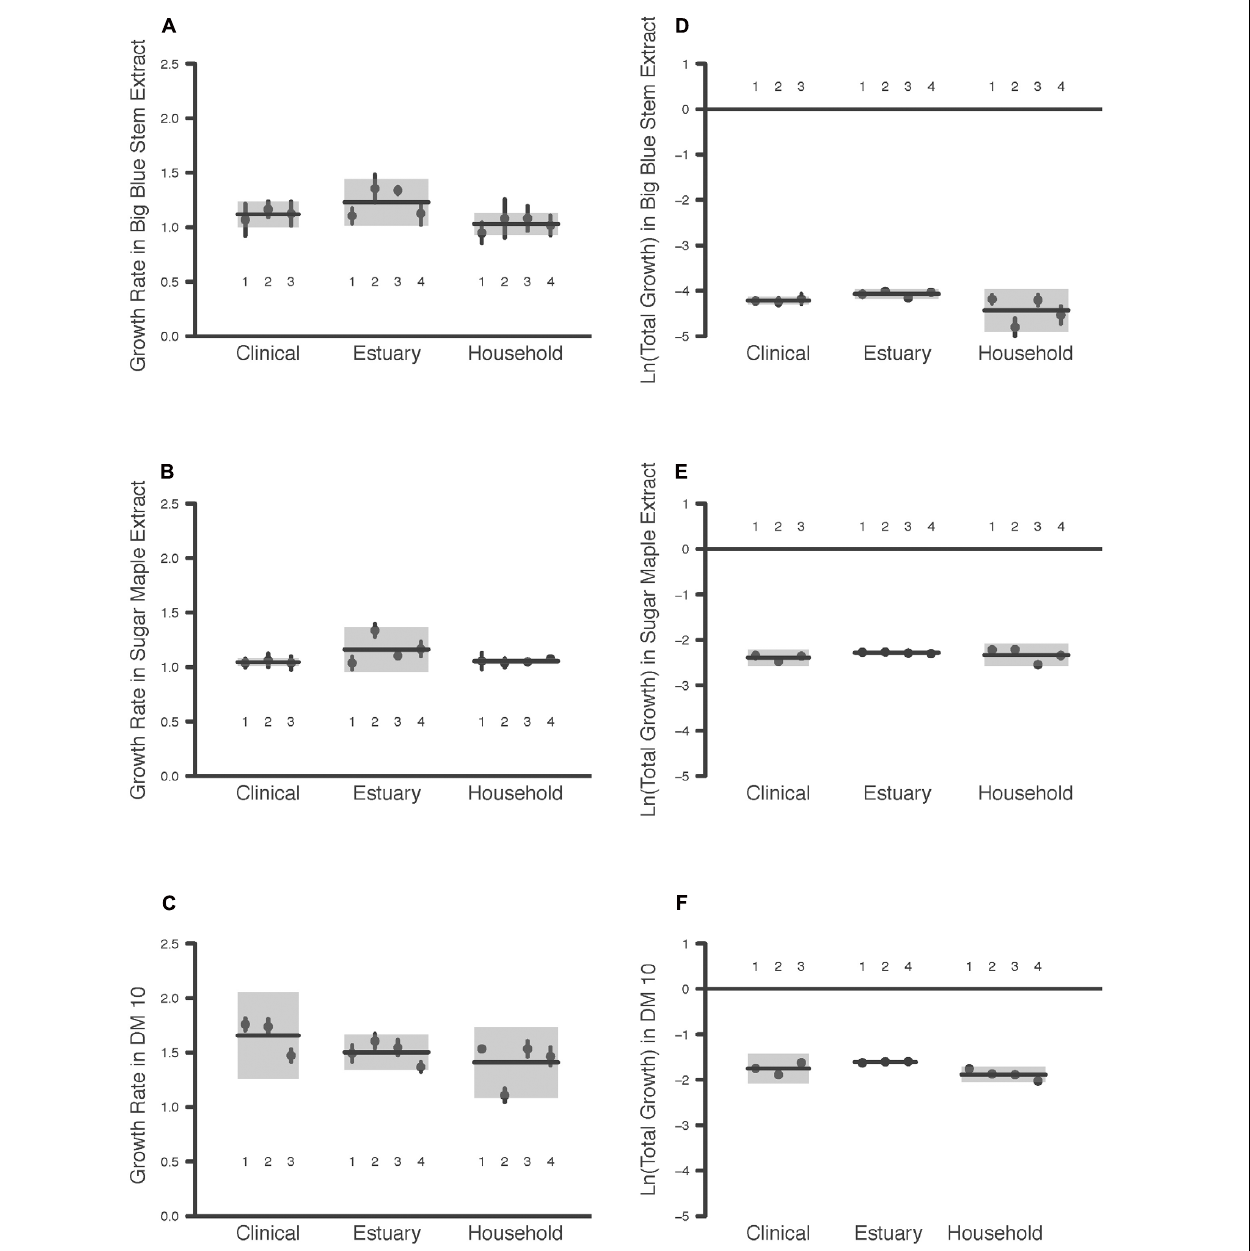
FIGURE 1 | Maximum Growth Rate and Total Growth of 11 P. aeruginosa Isolates in Three Media Types. Each point is the raw mean and 95% C.I. of four replicate measures per P. aeruginosa isolate, for bacteria taken from clinical, estuary and household environments. Two components of bacterial growth, the maximum growth rate and the total growth, were estimated from growth curve measurements of bacterial populations between 0 and 24 h (see text for details). Isolates are numbered for comparison among panels. Each line indicates the group mean, and each gray box indicates the 95% C.I. of the strains from a given environment. Maximum growth rates of bacteria were estimated in media prepared from (A) big bluestem grass, (B) sugar maple leaves, and (C) 10 µ g/mL glucose. Total growth of bacteria was estimated in media prepared from (D) big bluestem grass, (E) sugar maple leaves, and (F) 10 µ g/mL